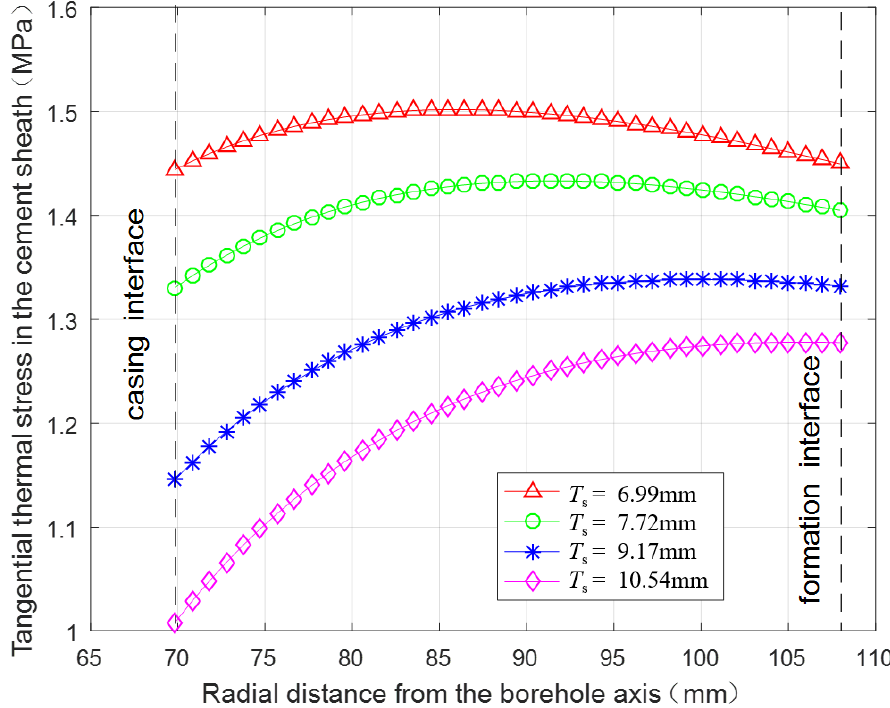
Figure 5. Radial distribution of the tangential thermal stress in the cement sheath under different wall thicknesses of the casing.